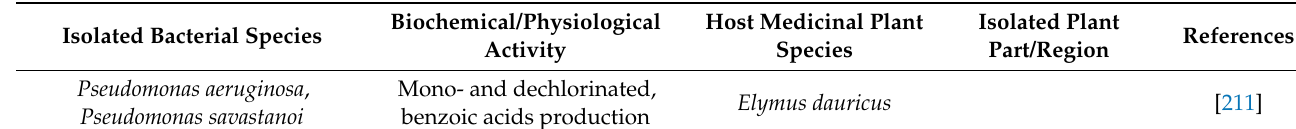
Table 3. Phytoremediation bacteria and associated secondary metabolites from medicinal and herbal plant